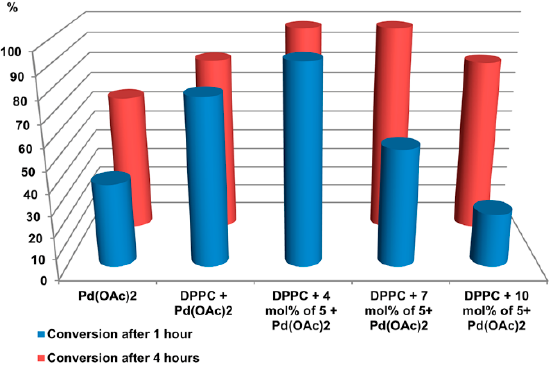
Figure 5. Conversion of 1-bromo-4-nitrobenzene after 1 or 4 h of reaction. C (1-bromo-4-nitrobenzene) = 10 mM, C (phenylboronic acid) = 11 mM, C (K 2 CO 3 ) = 30 mM, C (DPPC) = 1 м M, C( 5 mixed with DPPC) = 43, 65 and 98 μ M, C (Pd(OAc) 2 ) = 50 μ M, H 2 O, 70 °C.